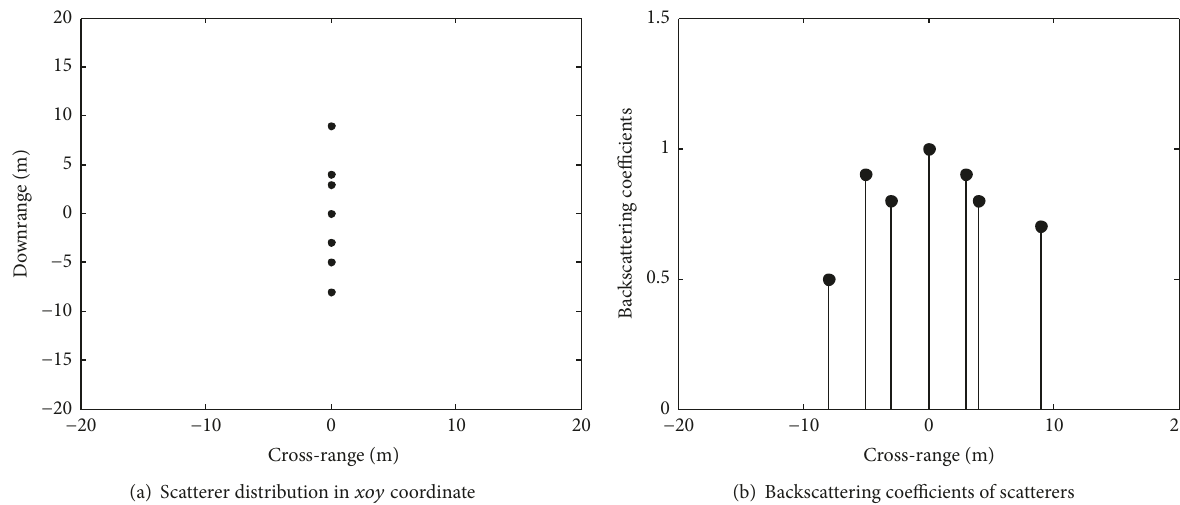
Figure 4: Modeling of the simple